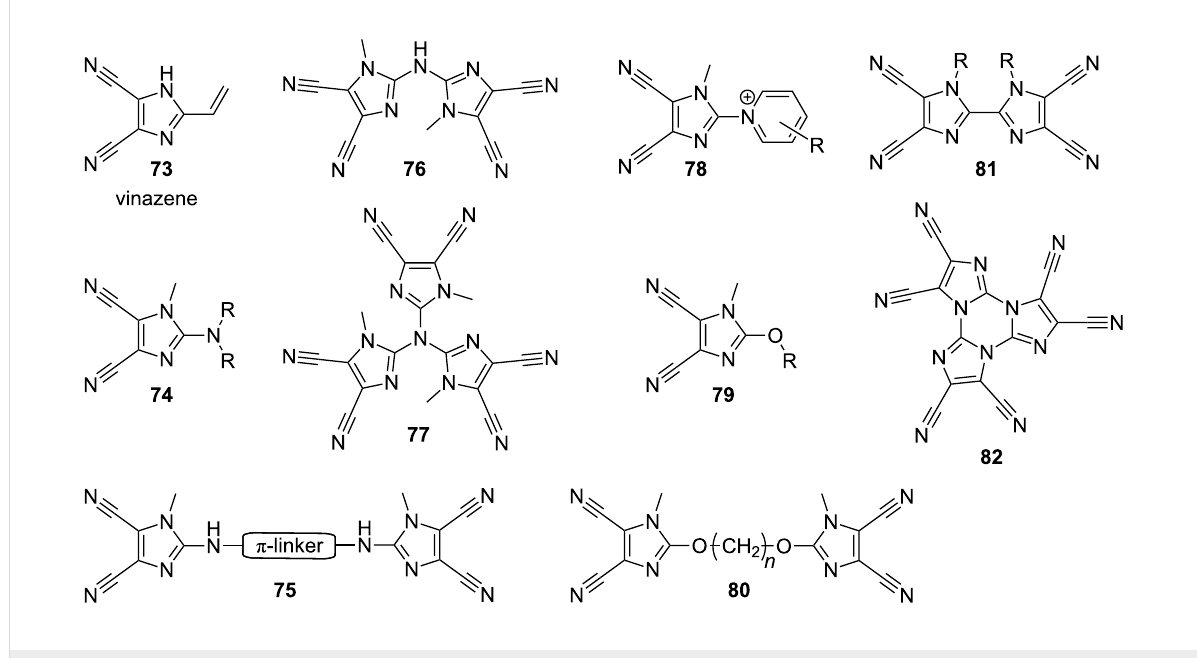
Figure 14: Overview of 4,5-dicyanoimidazole derivatives investigated by Rasmussen et al. [29,81-94].